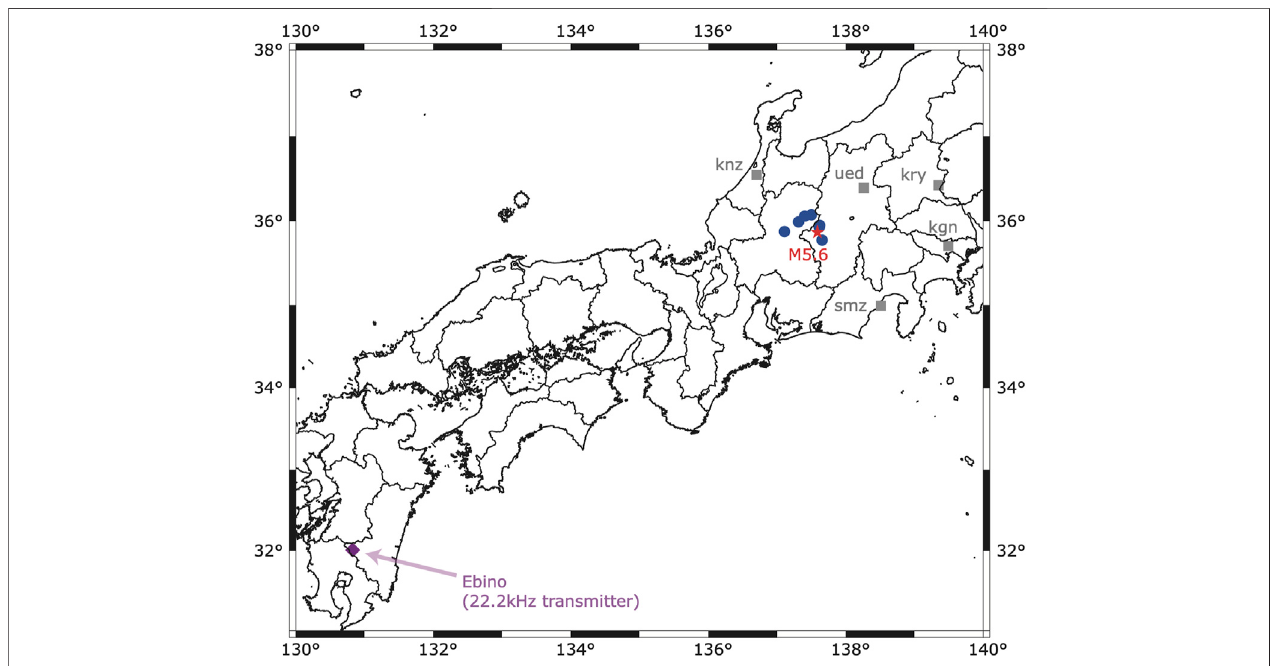
FIGURE1| Locationsofthe fi veobservationstations(graysquare)andtheepicenteroftheearthquake(redstar)onJune25,2017(M5.6,focaldepth (cid:1) 7 km).The blue solid circles are the source locations of possible precursory electromagnetic waves. The purple rhombus denotes the VLF transmitter at Ebino.